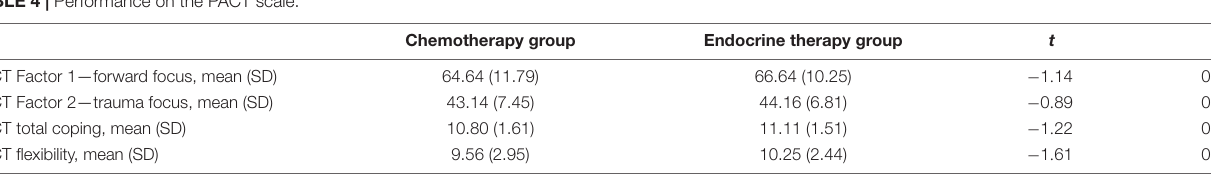
TABLE 4 | Performance on the PACT